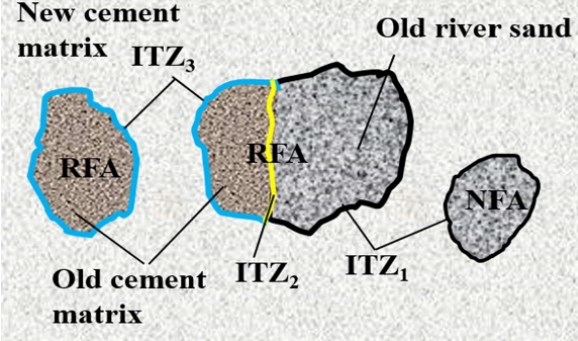
On this basis, some scholars continue to deepen the study of the microstructure of RAC and found that the Figure 1: Various types of ITZ in recycled aggregate concrete [26] strength of ITZ is more affected by the water-to-binder ra- tio. In the lower water-binder ratio concrete, its strength When the RAC is stressed, the cracks start from the frag- is mainly affected by the ITZ between the residual cemen- ile area near the ITZ and gradually spread to the aggregate titious materials, and the new ITZ mainly affects the high and cementitious materials, resulting in the destruction water-binder ratio concrete components. Therefore, in the of the entire concrete [24, 28]. It has been found that ITZ highwater-binderratioconcrete, even is composed of pores, Ca(OH) 2 , C-S-H gel, ettringite and cement particles [29]. At the same time, it can be found that the volume ratio of C-S-H in the ITZ between the aggregate